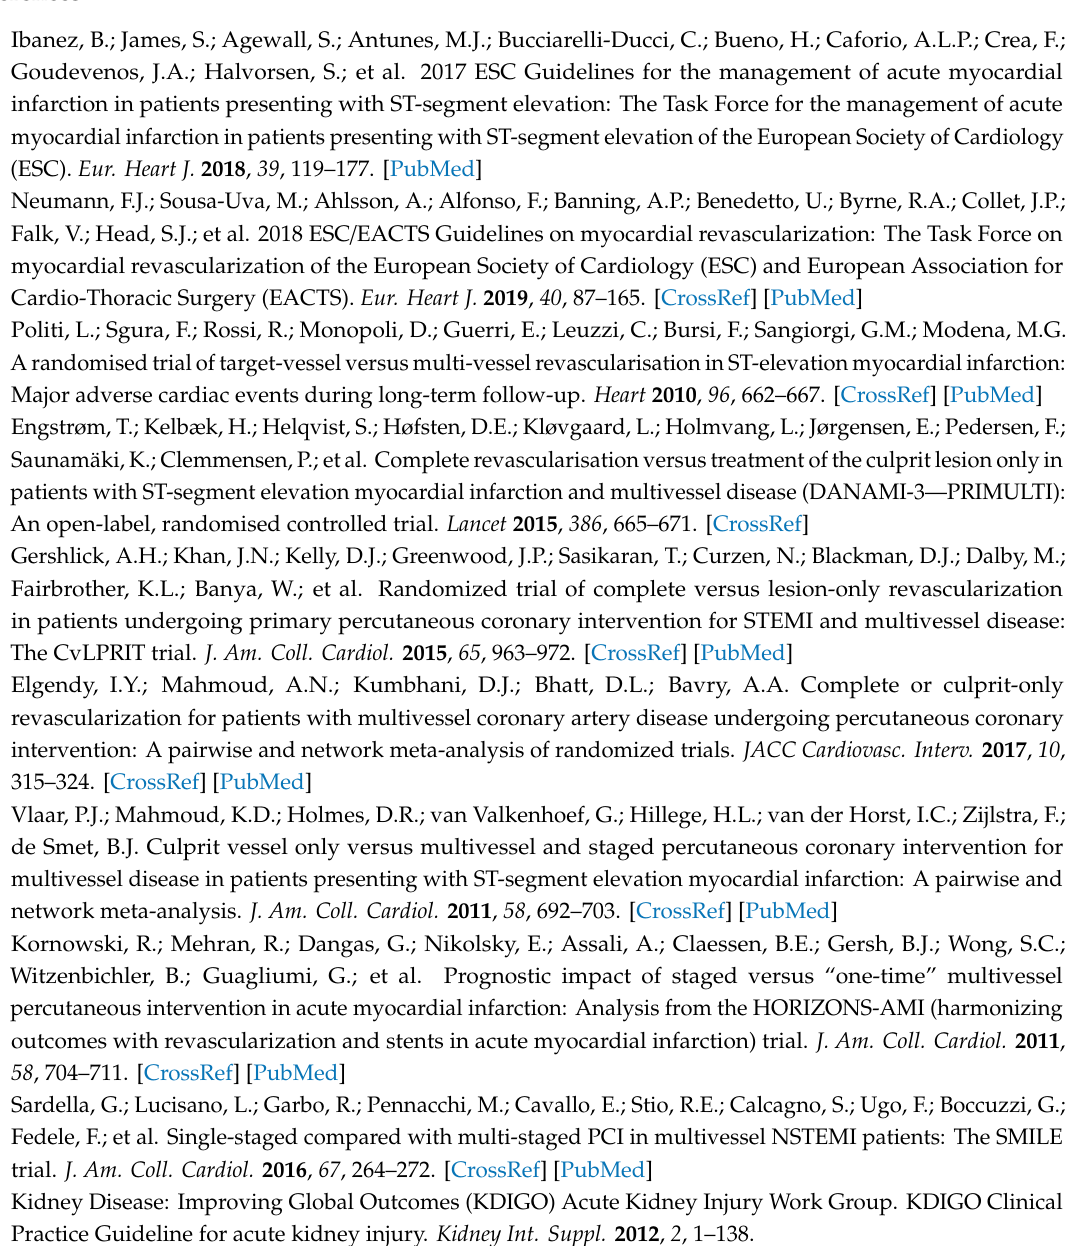
Table S1: a fully anonymized dataset in MS-Excel format with key data supporting our findings (“Table S1